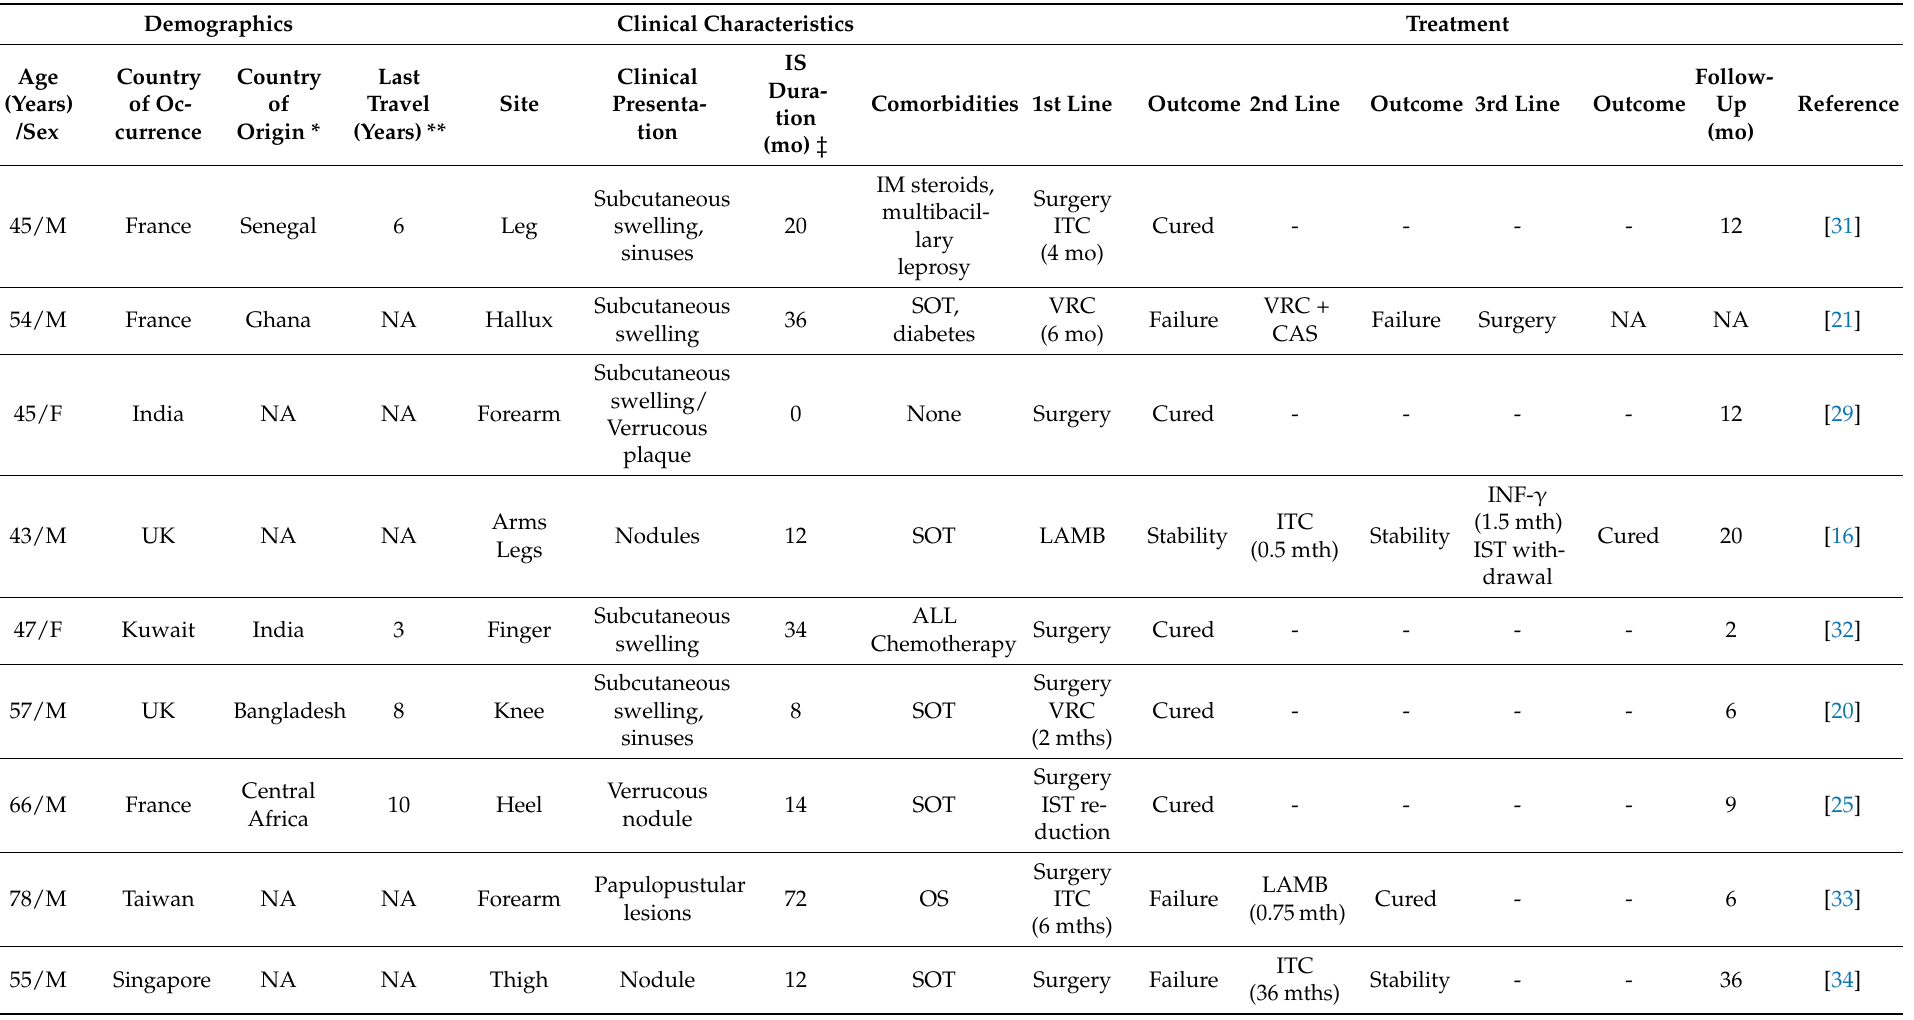
Table 2. Epidemiological, clinical characteristics, and treatment outcomes of the patients with M. romeroi phaeohyphomycosis in the